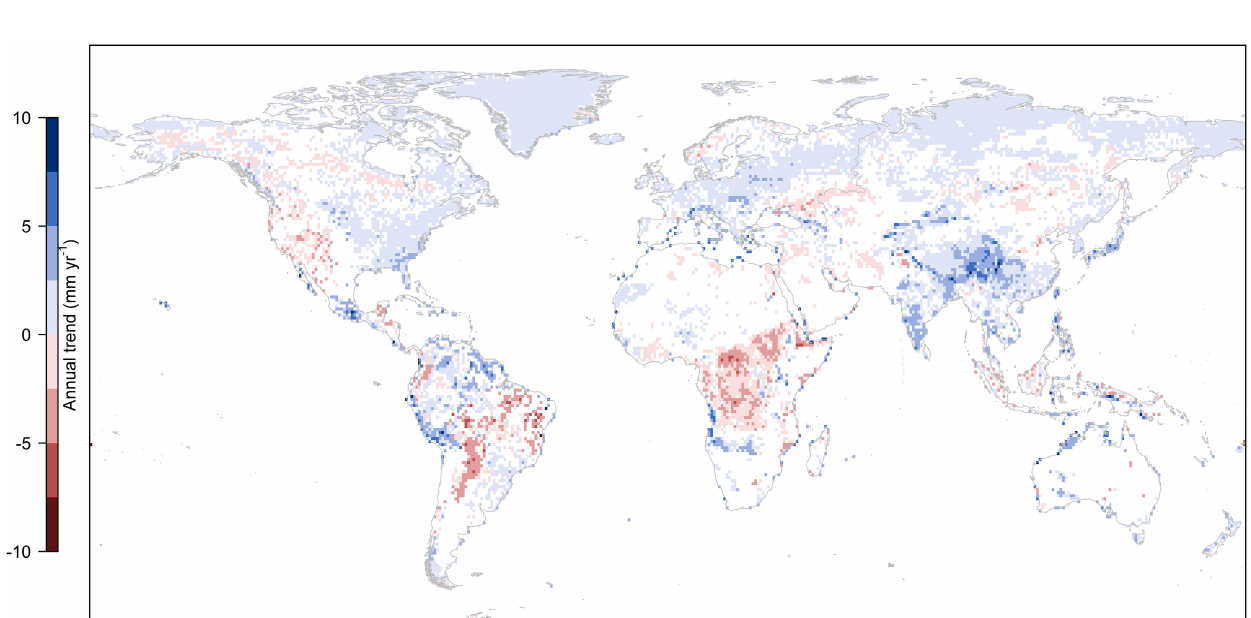
Figure 4. Spatial pattern of ET climate trends in DOLCE V3 over 1980–2018 derived using Mann–Kendall and Sen’s slope methods. Grid cells in white correspond to unreliable ET trends either because (i) the confidence interval of the slope encompasses a mix of negative and positive values or (ii) trend slopes computed for multiple, different random samples of ET within the interval ET ± uncertainty do not agree in